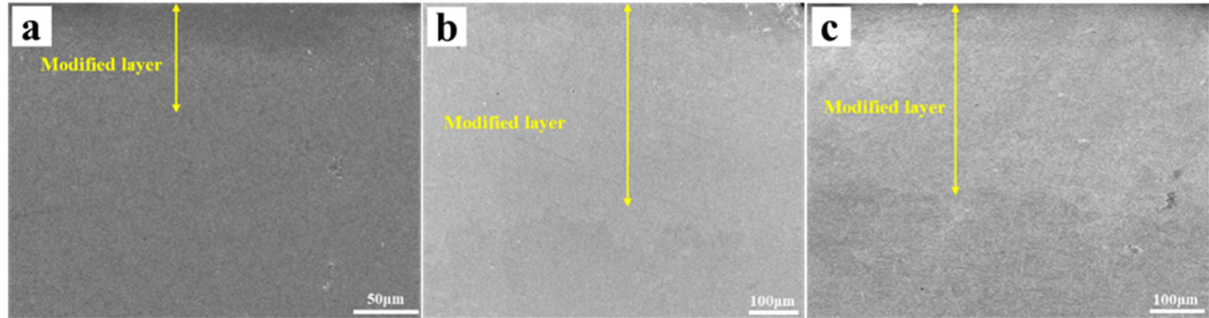
Figure 13. ( a ) Depth map of the C + 100P-modi fi ed layer; ( b ) depth map of the C + 200P-modi fi ed layer; ( c ) depth map of the C + 300P-modi fi ed layer.